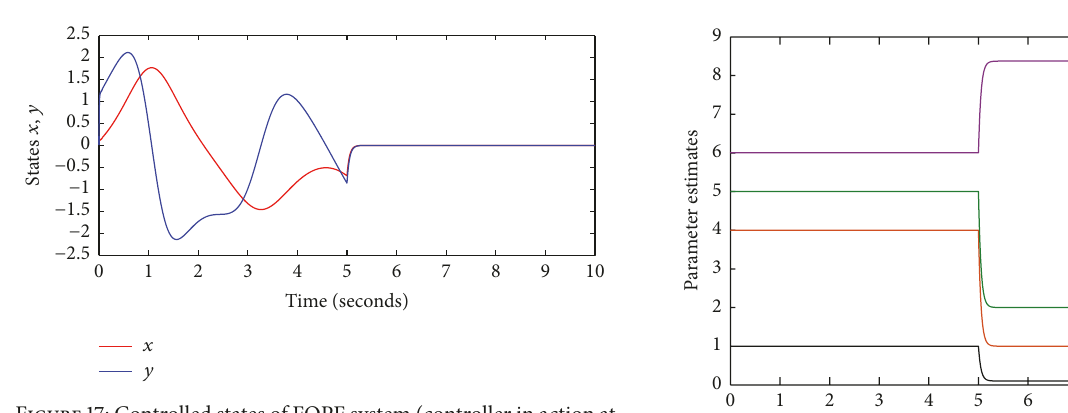
Figure 17: Controlled states of FOPF system (controller in action at 𝑡 = 5 s).